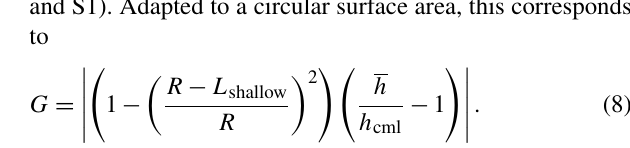
Ro tested. For Ro O(10 − 2 -10 − 1 ) , (cid:49)δ adv increases over